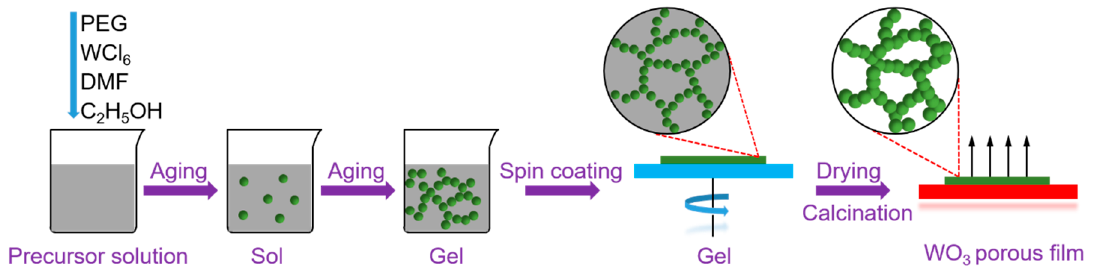
Figure 12. Schematic diagram of the formation process of WO 3 porous film.